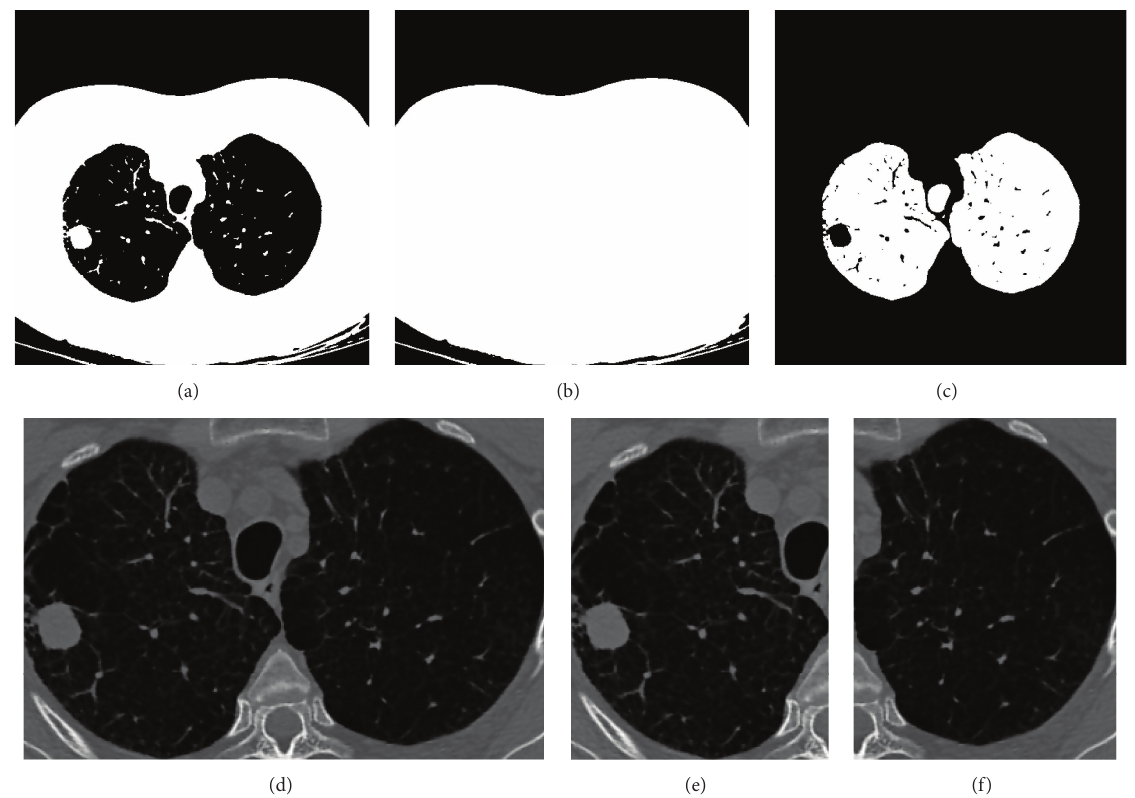
Figure 4: Segmentation and ROI selection. (a) Thorax binary image. (b) Filled image. (c) Lung segmentation. (d) Rectangular ROI of both lungs. (e) Right lung (cancer). (f) Left lung